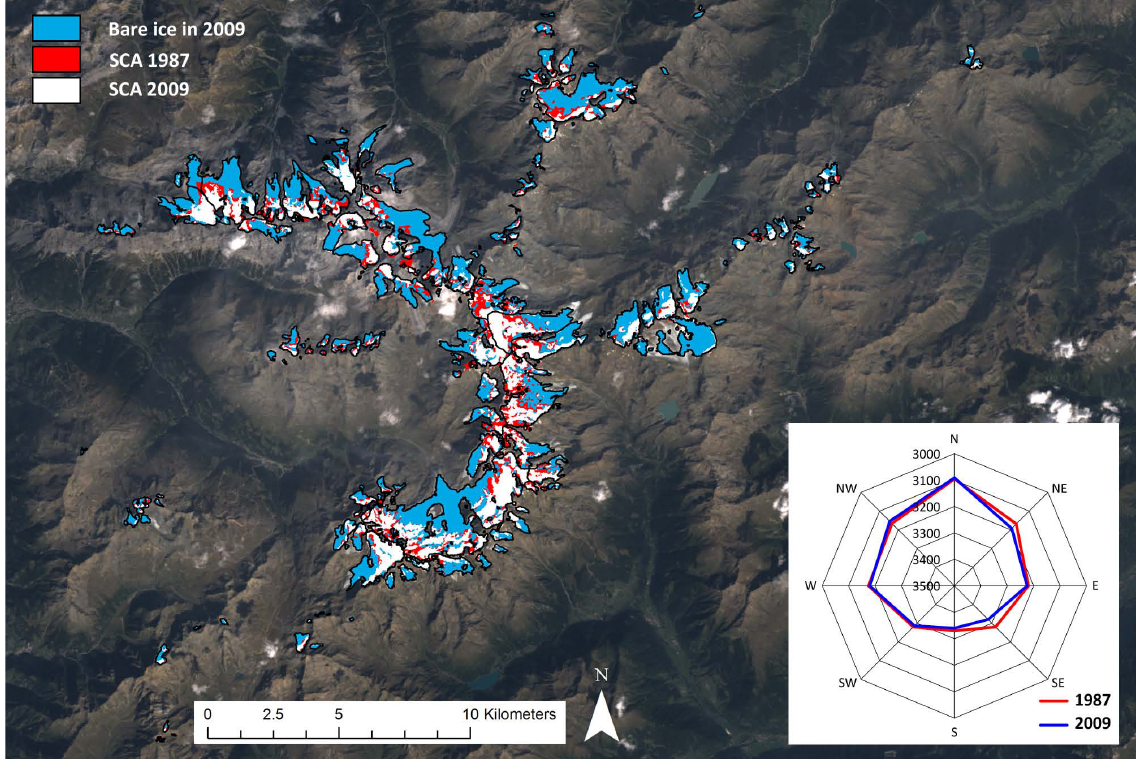
Fig. 12. Snow-covered area in the late summer of 1987 (red and white) and 2009 (white only). Light blue represents bare ice in 2009; white+red+blue=glacier area in 2009. The radar chart shows the snow line altitude versus main aspect direction in both